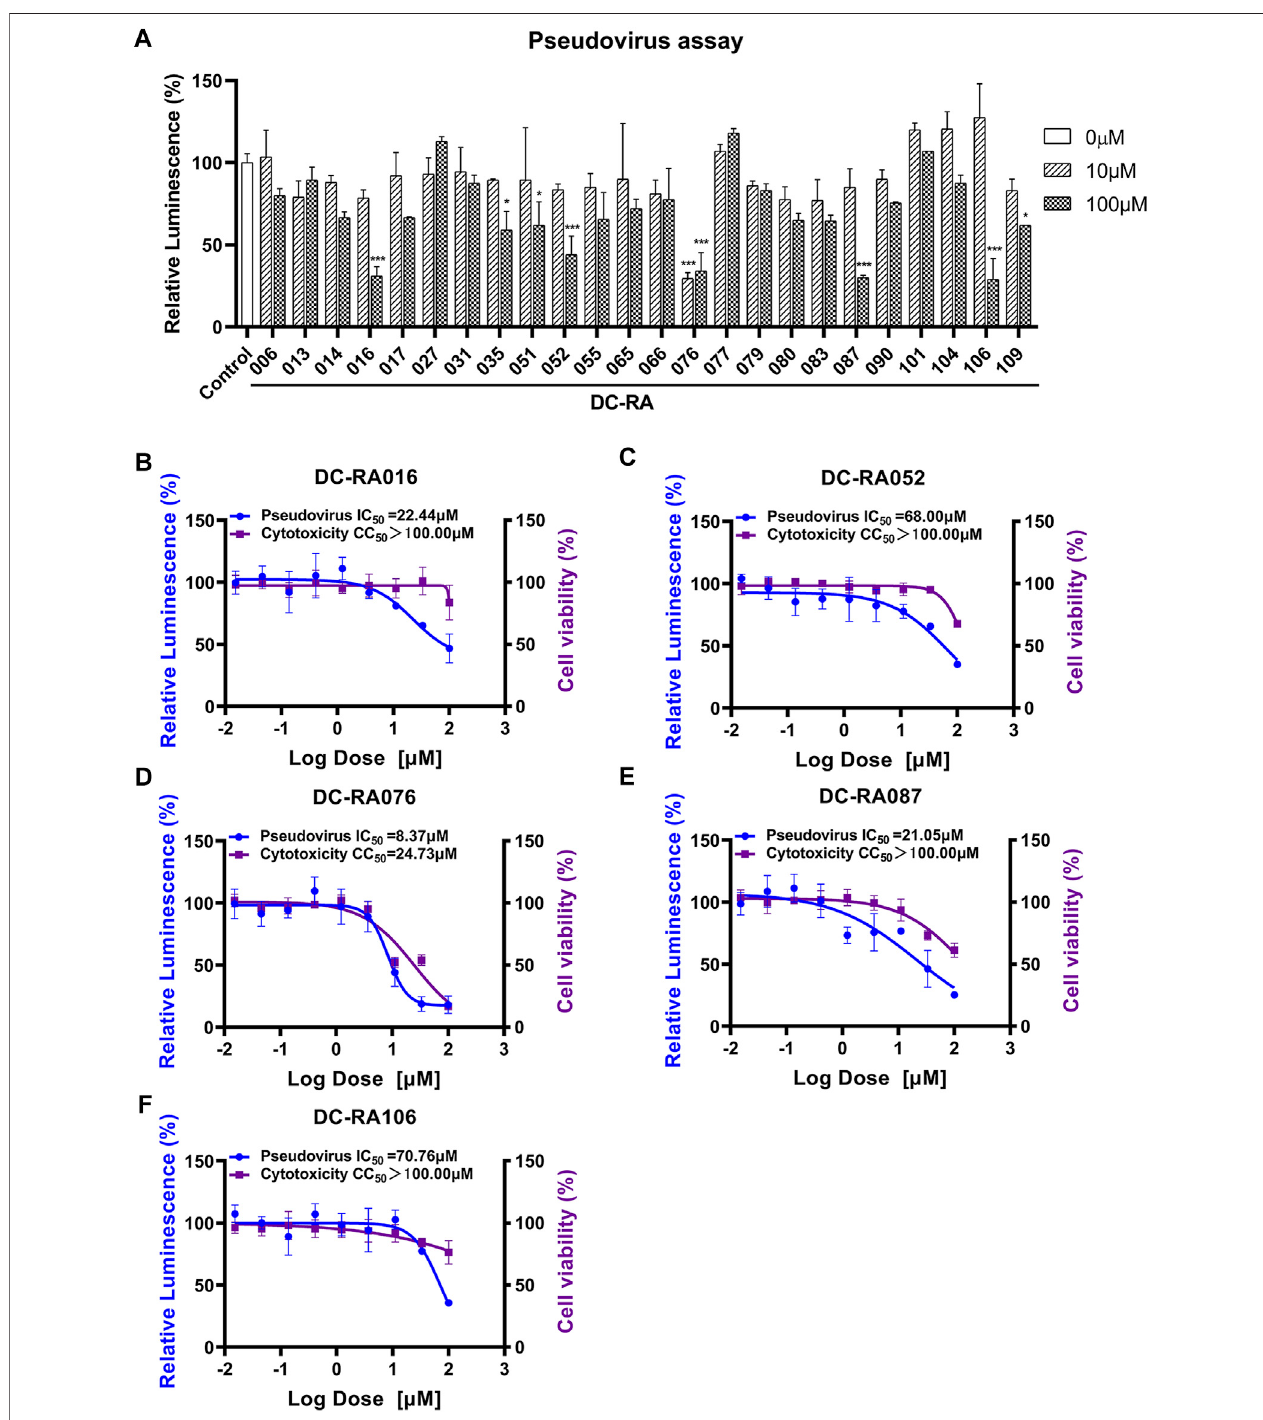
FIGURE4| Anti-SARS-CoV-2-S pseudovirusactivitiesand cytotoxicities ofseveralcompounds. (A) Determining Anti-SARS-CoV-2-S pseudovirusactivitiesof24 compoundsshowingthepotentblockingactivitiesagainstSARS-CoV-2S-RBD/ACE2interactionintheinitialNanoBiTassayusingthetwoconcentrations(10,100 μ M); (B-F) IC 50 and CC 50 values of fi ve compounds: (B) DC-RA016, (C) DC-RA052, (D) DC-RA076, (E) DC-RA087, (F) DC-RA106; Relative Luminescence (%) standing for the infection of SARS-CoV-2-S pseudovirus (blue), cell viability (purple).